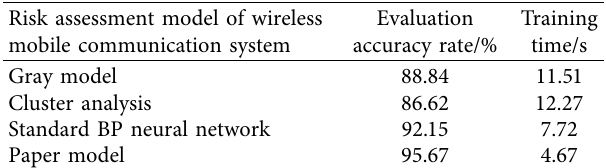
Table 2: Comparison of risk assessment results of wireless mobile power communication system with classical